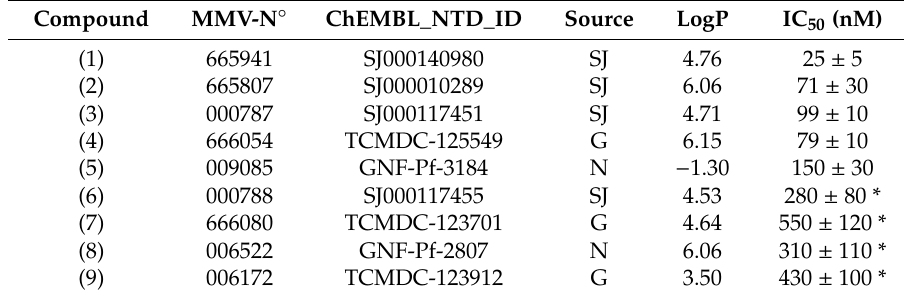
Table 1. Overview of the nine most e ff ective MMV Malaria Box compounds. The IC 50 s were determined from the inhibition curves depicted in Figure 2 as described in Section 4.4. The IC 50 values were calculated after the logit-log transformation of the mean values and are given in nM with 95% confidence intervals. *, values that were extrapolated. Sources: SJ, St. Jude; G, GlaxoSmithKline; N, Novartis. Compound MMV-N ◦